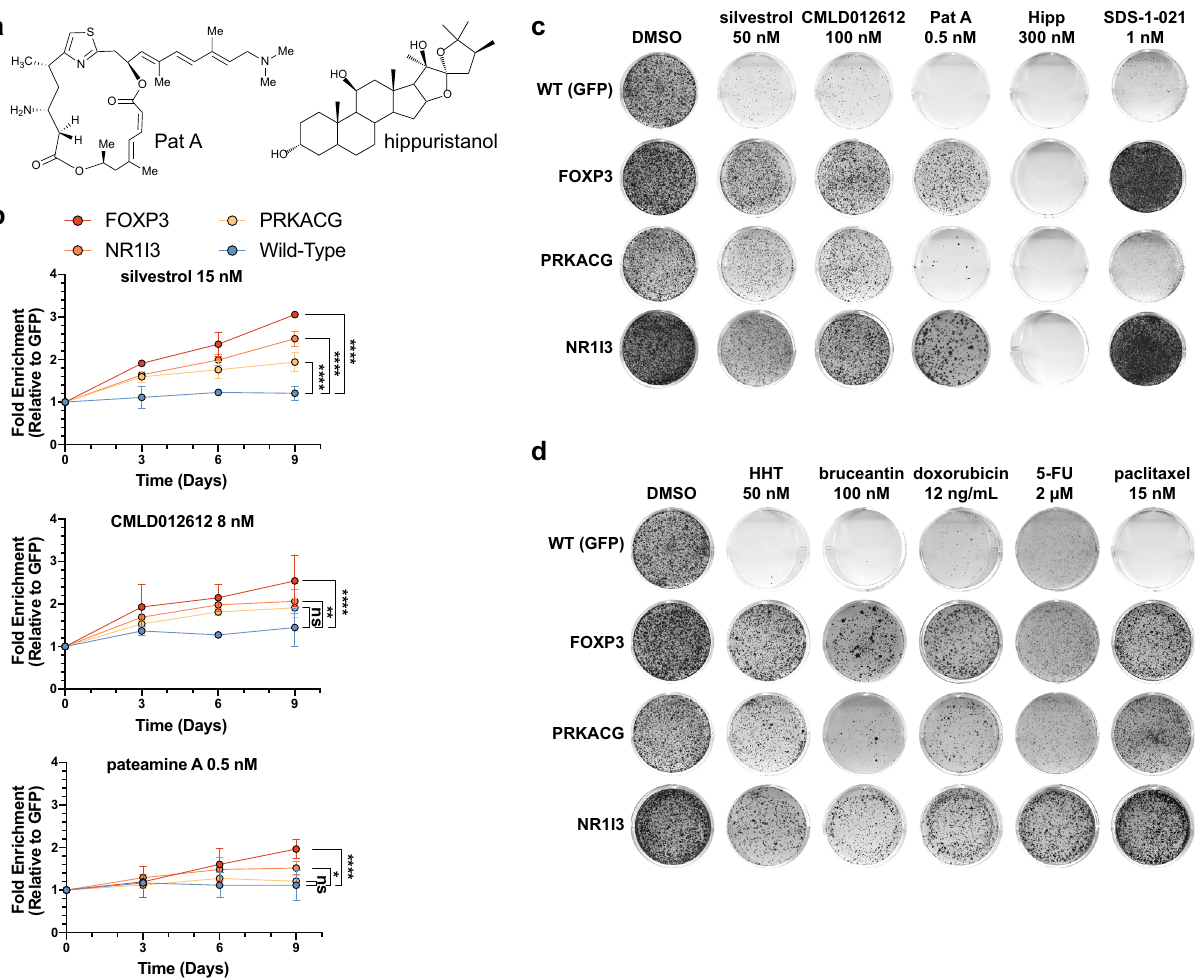
Figure 3. FOXP3 and NR1I3 confer a robust multi-drug cross-resistant phenotype. ( a ) Structures of Pat A and Hipp. ( b ) Competition assays with GFP + -transduced or gene-of interest-transduced Hap1 cells exposed to silvestrol, CMLD012612, or Pat A. Fold change relative to the GFP + transduced cell line on day 0 is shown. n = 3 ± SD, statistical significance determined using a two-way ANOVA, followed by Dunnett’s multiple comparison test. P -value cut-offs: ns ( P > 0.05), *(0.05 ≥ P ≤ 0.01), **(0.01 ≥ P ≤ 0.001), ***(0.001 ≥ P ≤ 0.0001), **** ( P ≤ 0.0001). ( c ) Representative experiments from colony formation assays in the indicated Hap1 cell lines following treatment with eIF4A inhibitors for 6–21 days are shown. n ≥ 3. ( d ) Representative experiments from colony formation assays in the indicated Hap1 cell lines following exposure to compounds for 6–21 days. n ≥